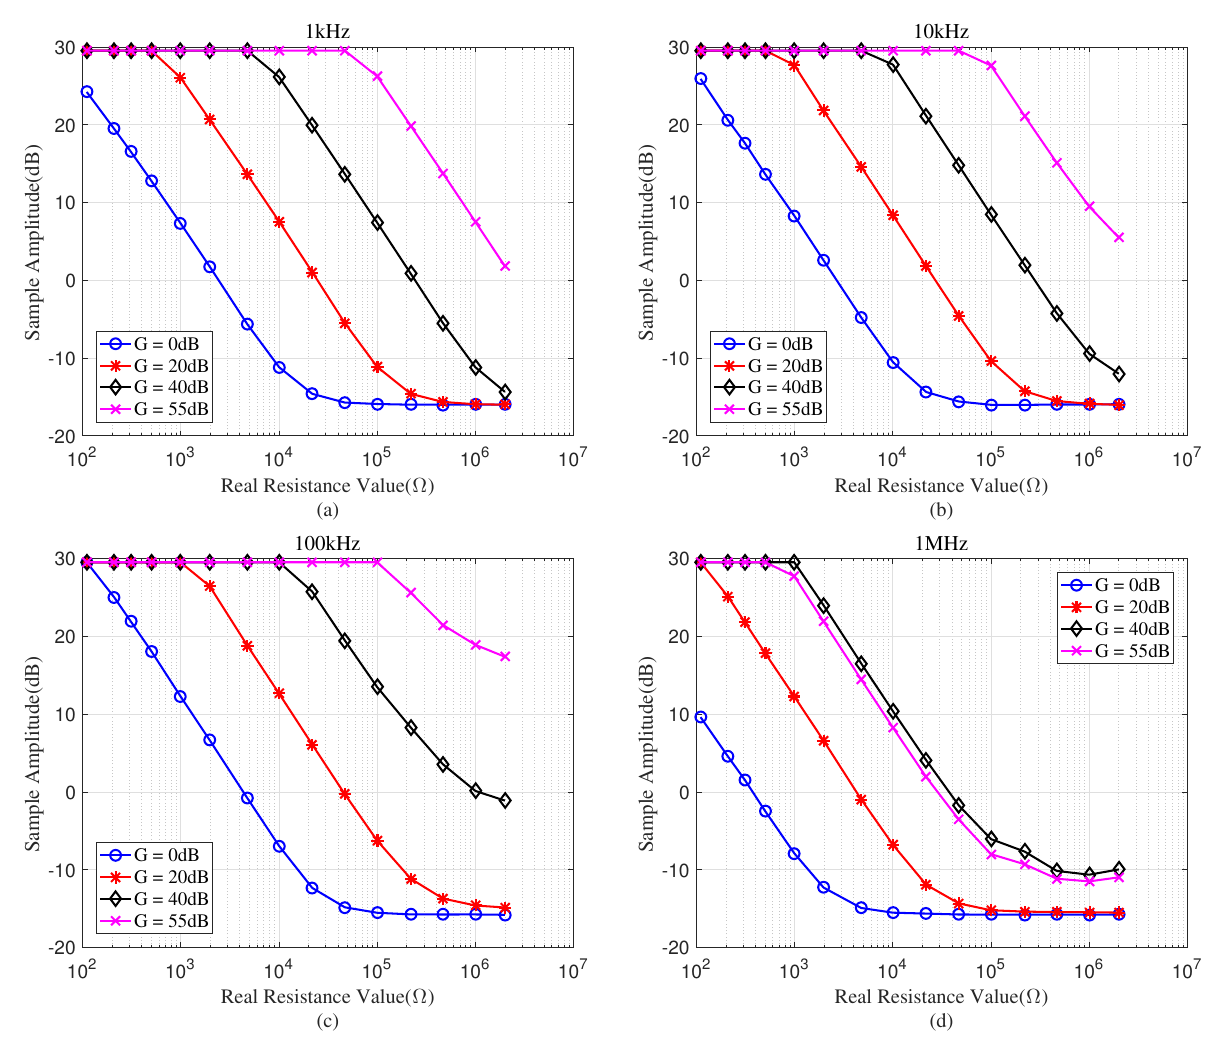
Figure 7. The amplitudes of samples in different resistor measurements when the excitation signal frequency is ( a ) 1 kHz, ( b ) 10 kHz, ( c ) 100 kHz and ( d ) 1 MHz, respectively. G stands for the gain of receiving